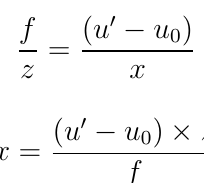
Figure 3. Relationship between a different coordinate system (world( X x (cid:48) ) coordinate system). I